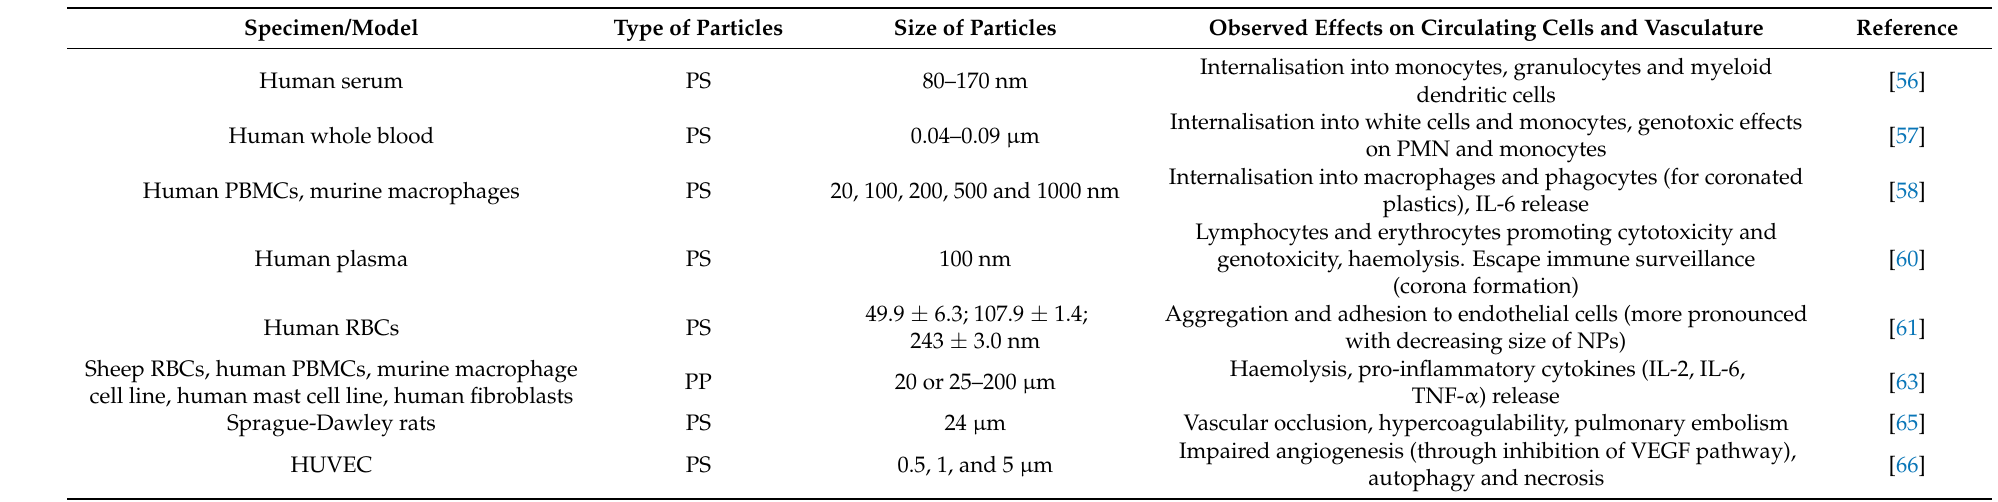
Table 3. Summary of MPs/NPs characteristics and effects on CV system of mammalian. PBMC: Peripheral Blood Mononuclear Cells; RBCs: red blood cells; HUVEC: Human Umbilical Vein Endothelial Cells; PS: polystyrene; PP: polypropylene; PMN: Polymorphonuclear leukocytes.